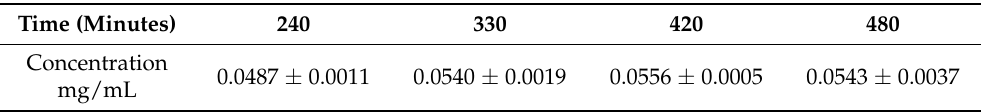
Table 2. Time selection for